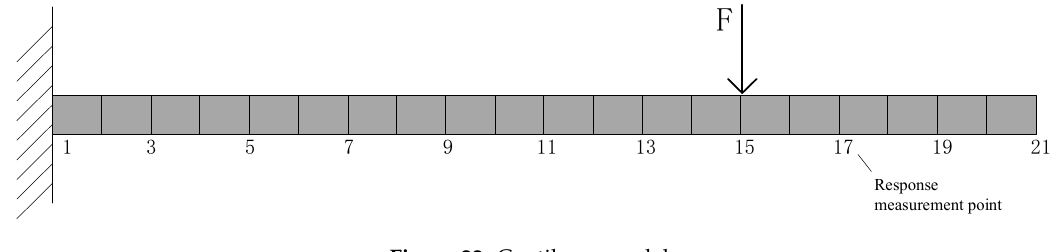
Figure 22. Cantilever model.